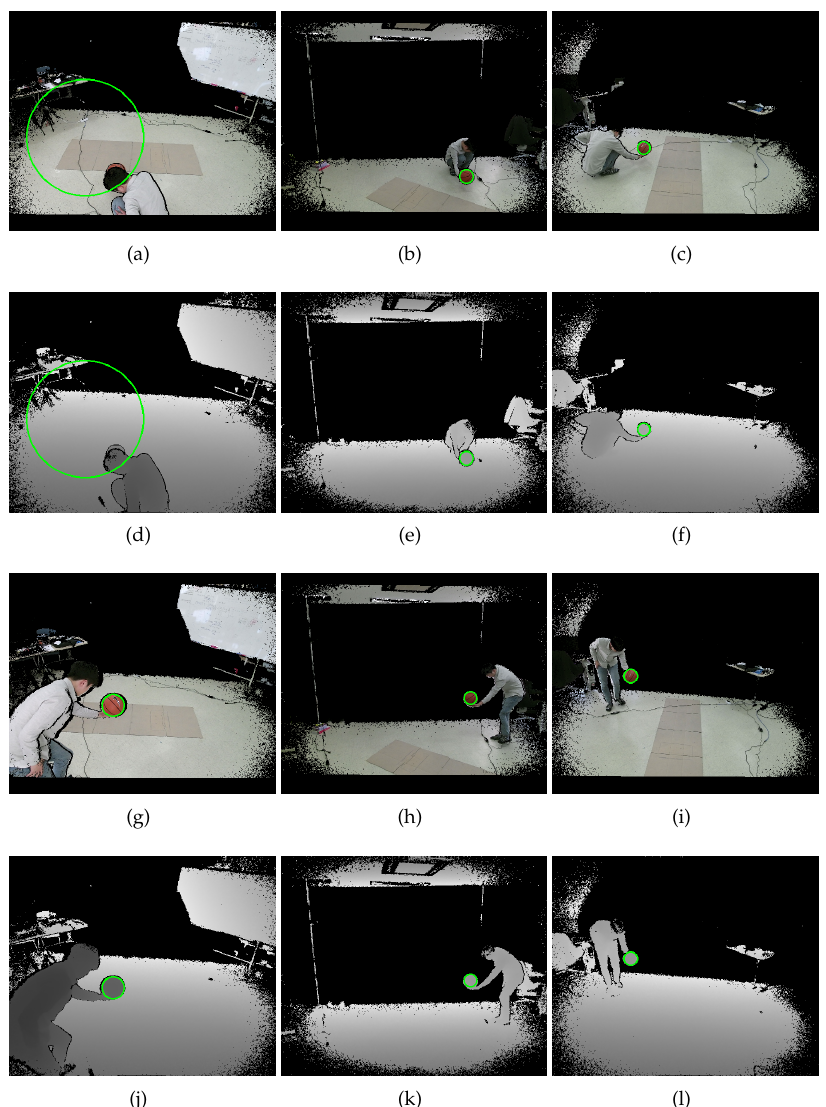
Figure 19. Examples of aligned and undistorted color and depth image pairs of the static basketball set. The green empty circles represent sphere regions detected by the proposed method. ( a ), ( b ), ( c ) show corresponding color images, and ( d ), ( e ), ( f ) show their corresponding depth images. ( g ), ( h ), ( i ) show another triple of corresponding color images, and ( j ), ( k ), ( l ) show their corresponding depth images.